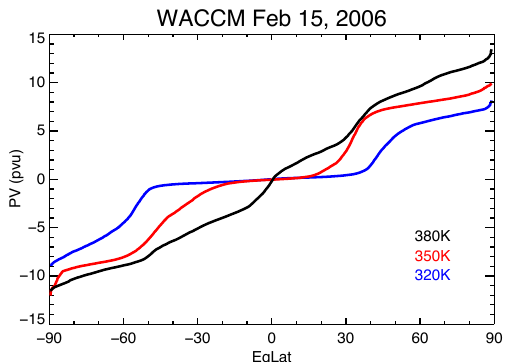
Fig. 2. The relationship of PV and EqLat for three middleworld isentropes on 15 February